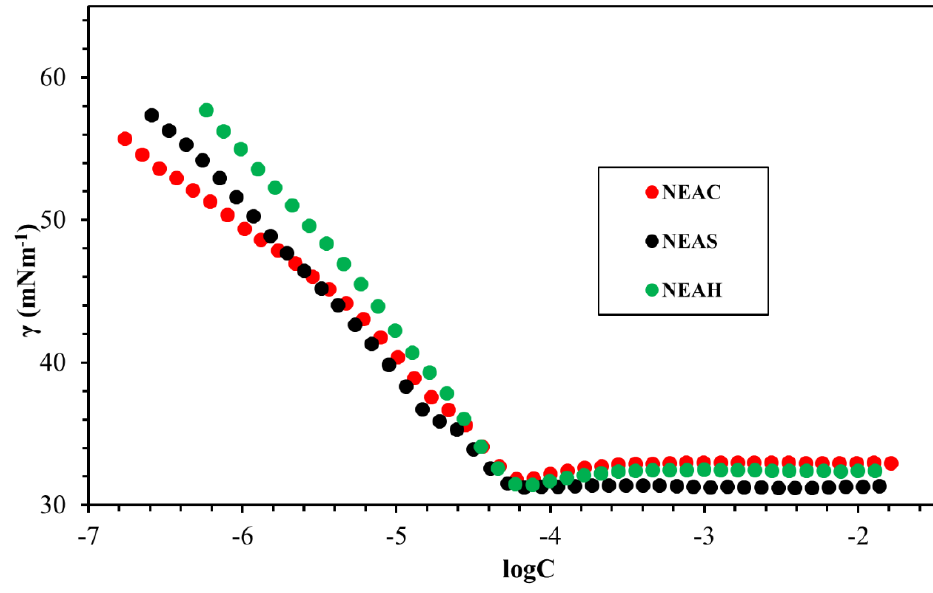
Figure 9. The surface tension-logC plots of NEAC, NEAS, and NEAH in 1M NaCl at 30 °C.